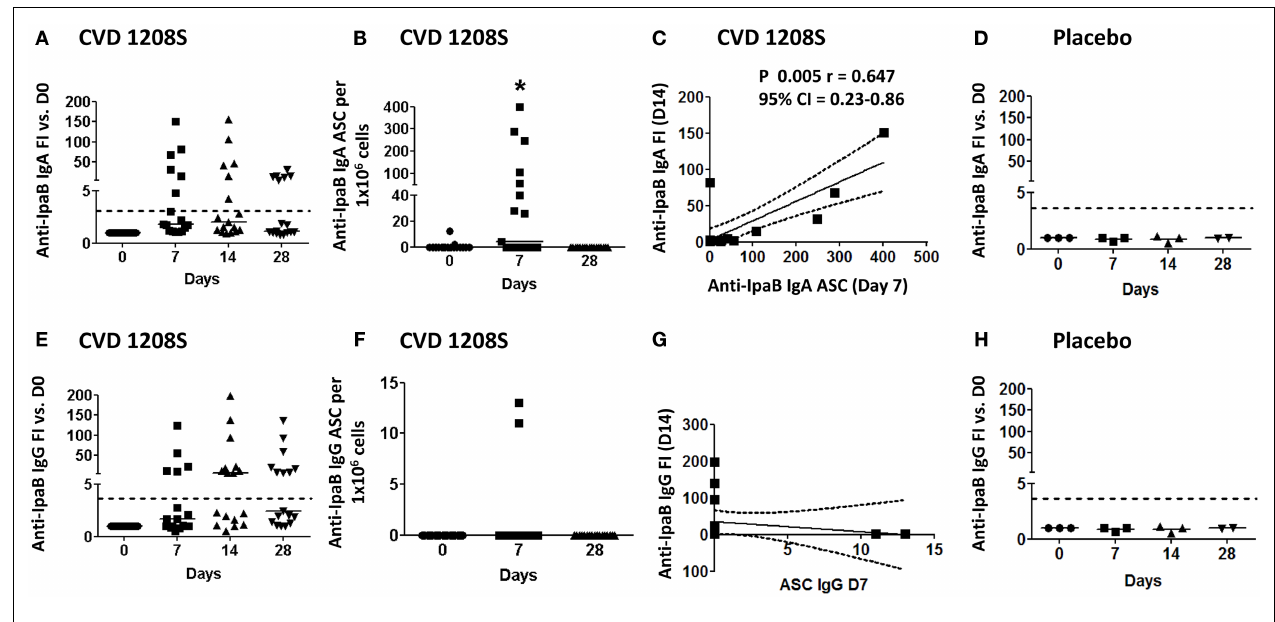
(fold-increase at day 14) and ASC (day 7). (D,H) Sera anti-LPS IgA and IgG in placebo volunteers ( n = 3). In all plots each symbol indicates an individual volunteer. Dotted lines indicate seroconversion (fourfold-increase over day 0). Horizontal bars represent the median in all graphs. Asterisks show statistical significance when compared to day 0 (* p <